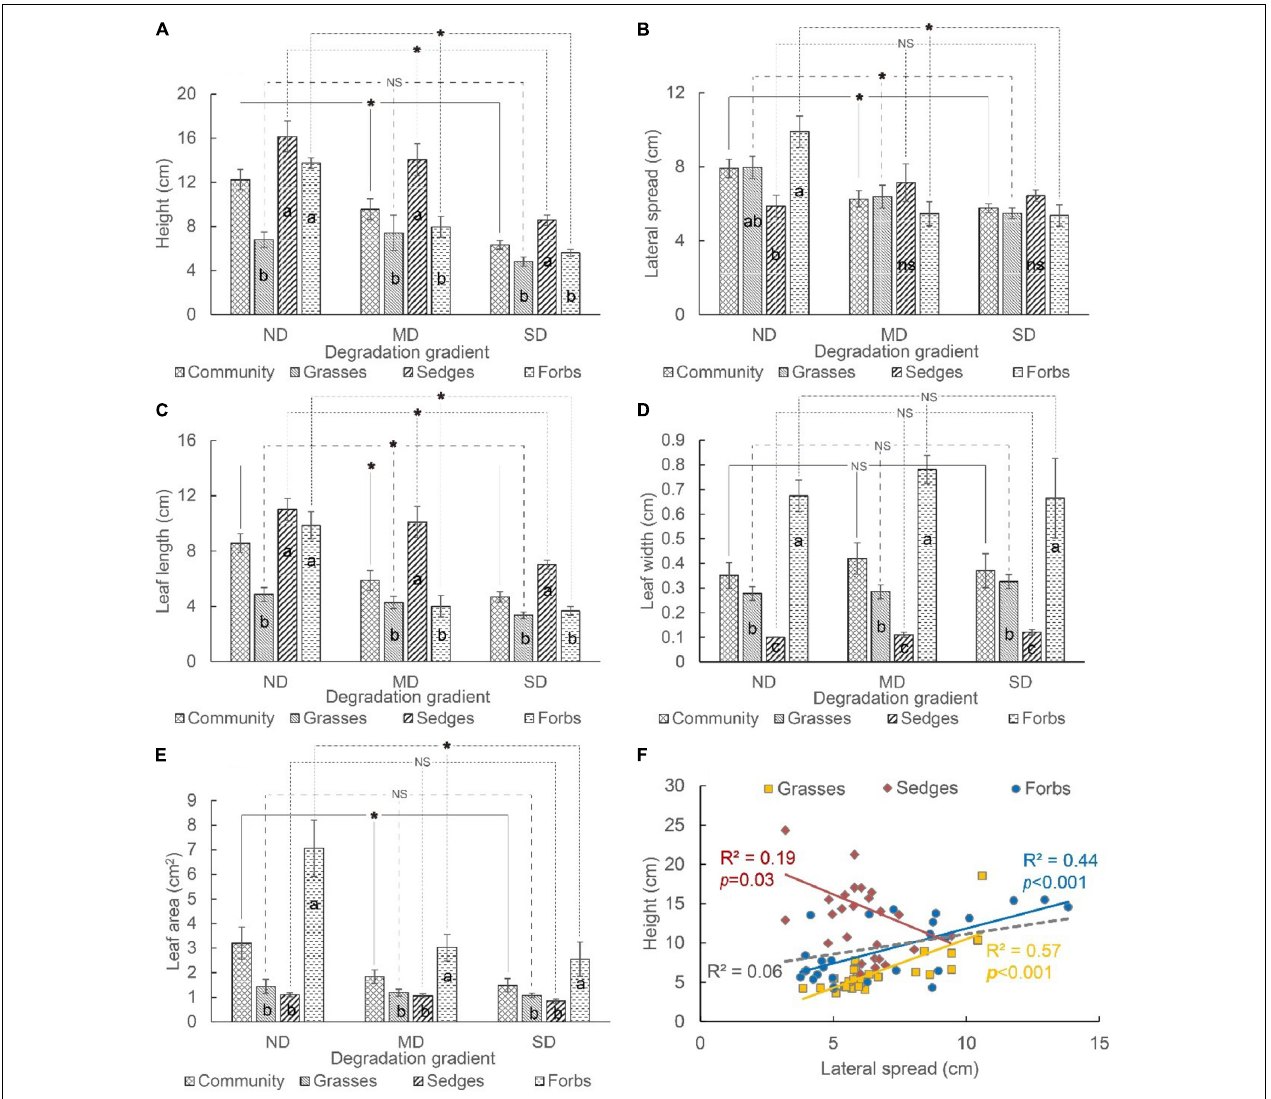
FIGURE 4 | The (A) height, (B) lateral spread, (C) leaf length, (D) leaf width, and (E) leaf area of different functional groups (i.e., grasses, sedges, and forbs) in different degradation gradients. The relationship between plant height and lateral spread varied among different functional groups (F) . The “*” means a significant difference between functional groups among degradation gradients. The different lowercase letters mean significant differences between functional groups in each degradation gradient. “NS” and “ns” mean no